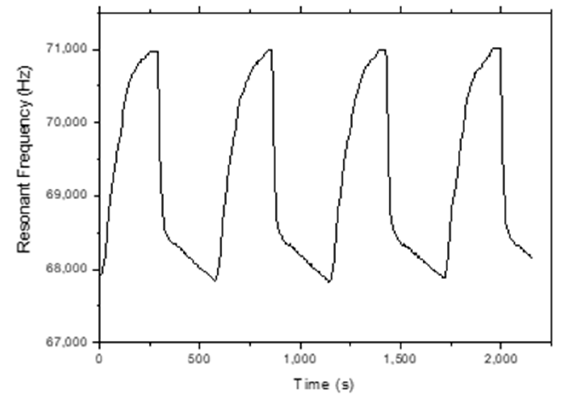
Figure 11. Frequency response of TiO 2 -NT-coated MES-4 for cycling between 5% and 95% RH. Sensors 2020 , 20 , x FOR PEER REVIEW